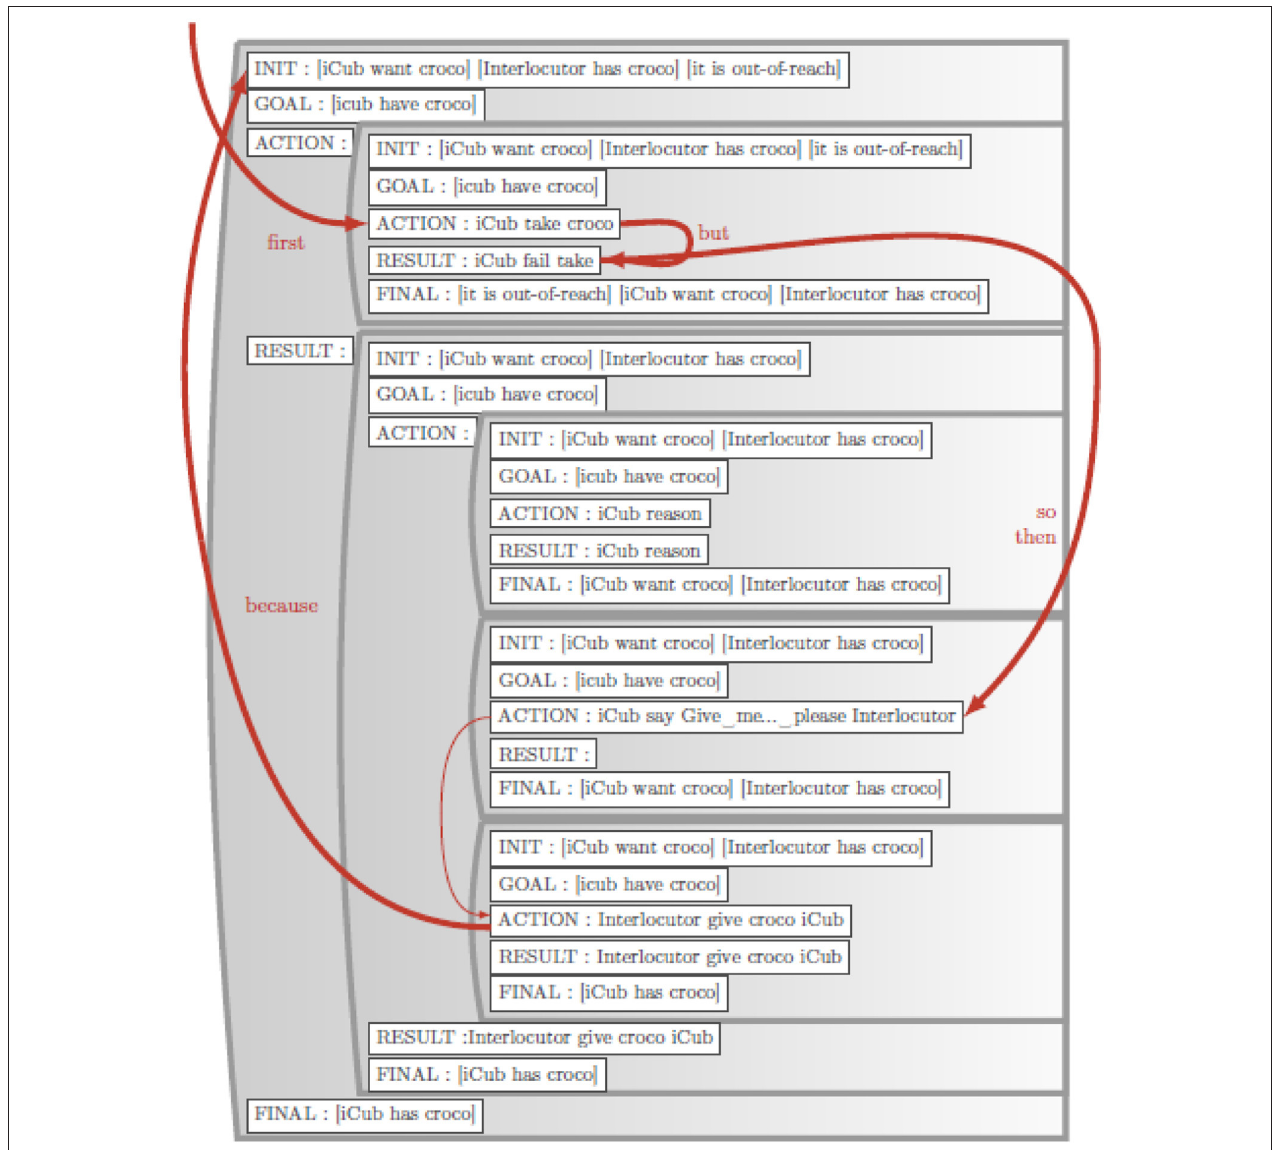
FIGURE 2 | Situation model contents example. Example of a situation model created automatically from the ABM via the ABMtoSM module. The narrative links (in red) were created during the Situation Model Enrichment via narrative with the NCx to SM module.